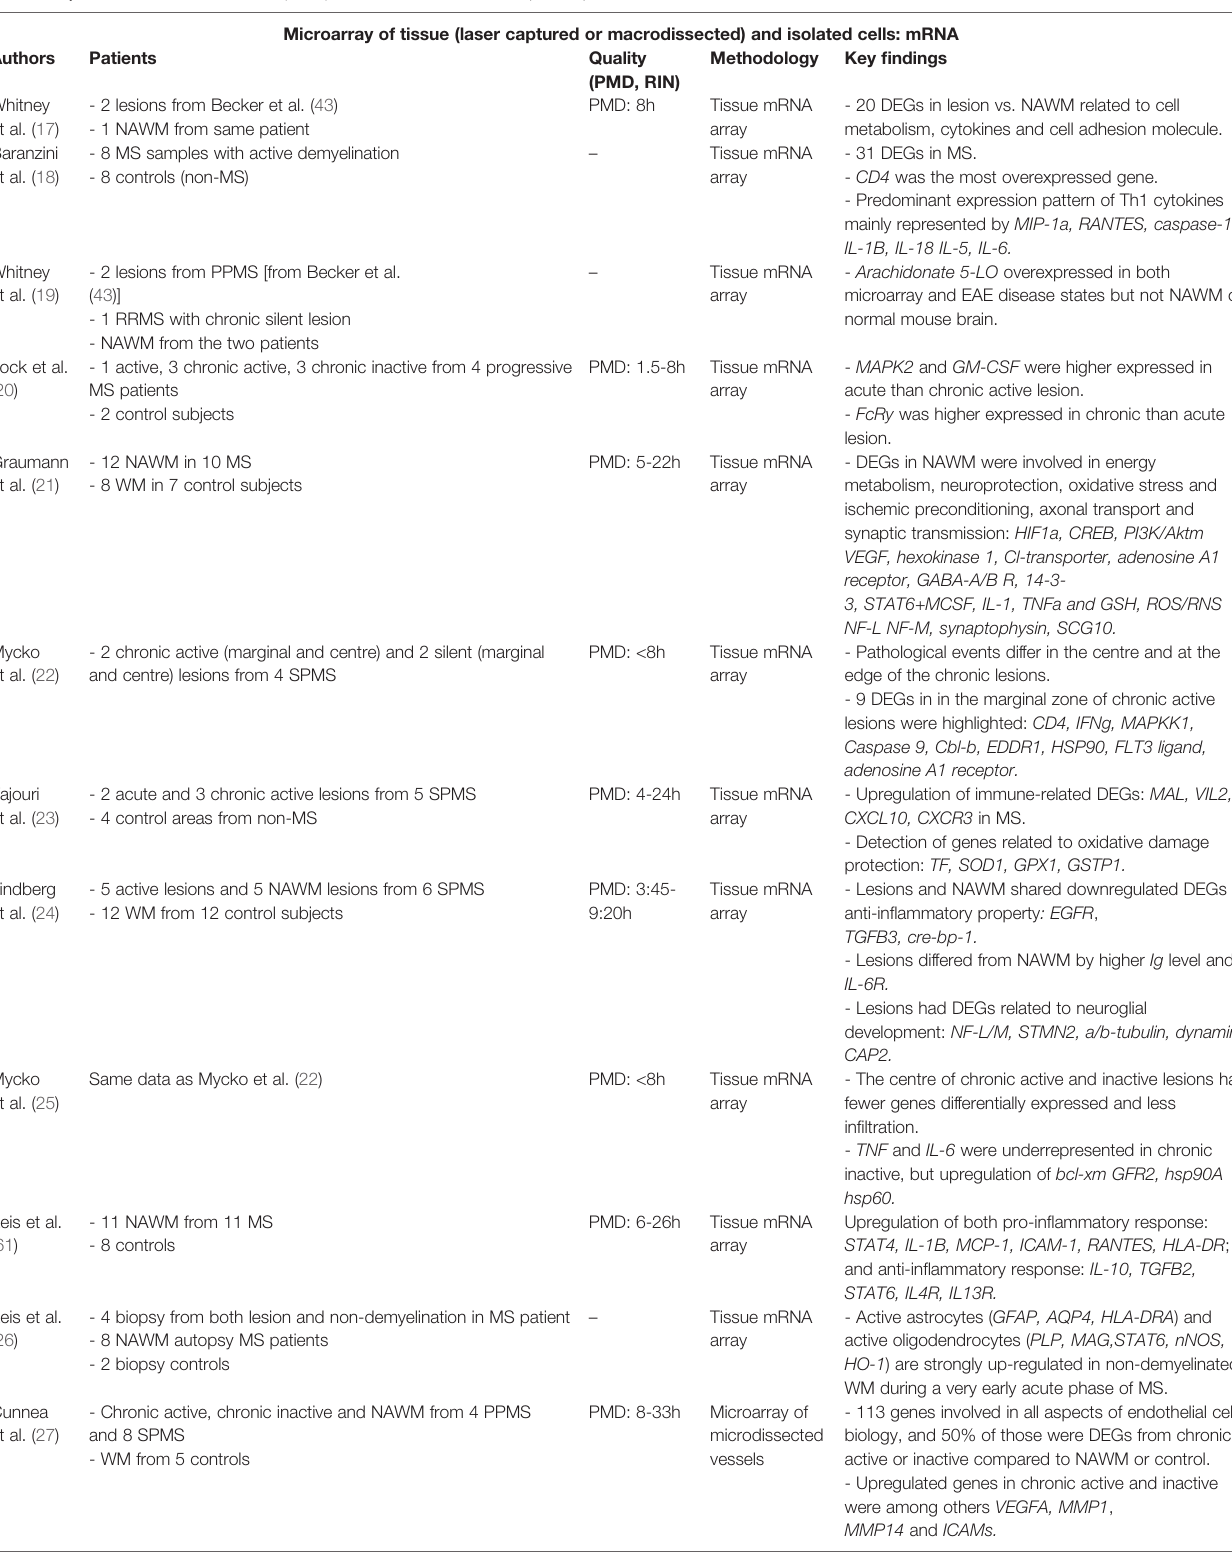
TABLE 2 | An overview of the studies (n=49) that examined the transcriptome pro fi le in human MS brain tissue. Microarray of tissue (laser captured or macrodissected) and isolated cells: mRNA